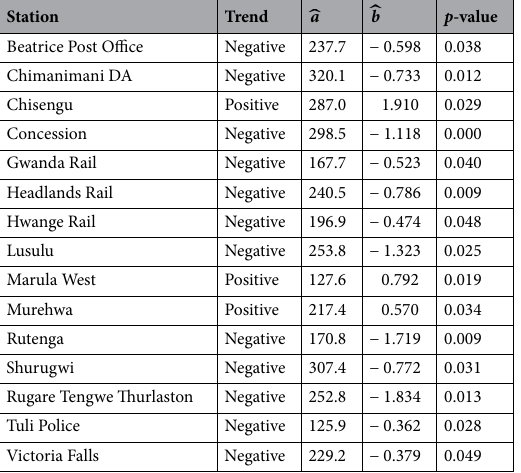
Table 4. Stations exhibiting significant trends in the location